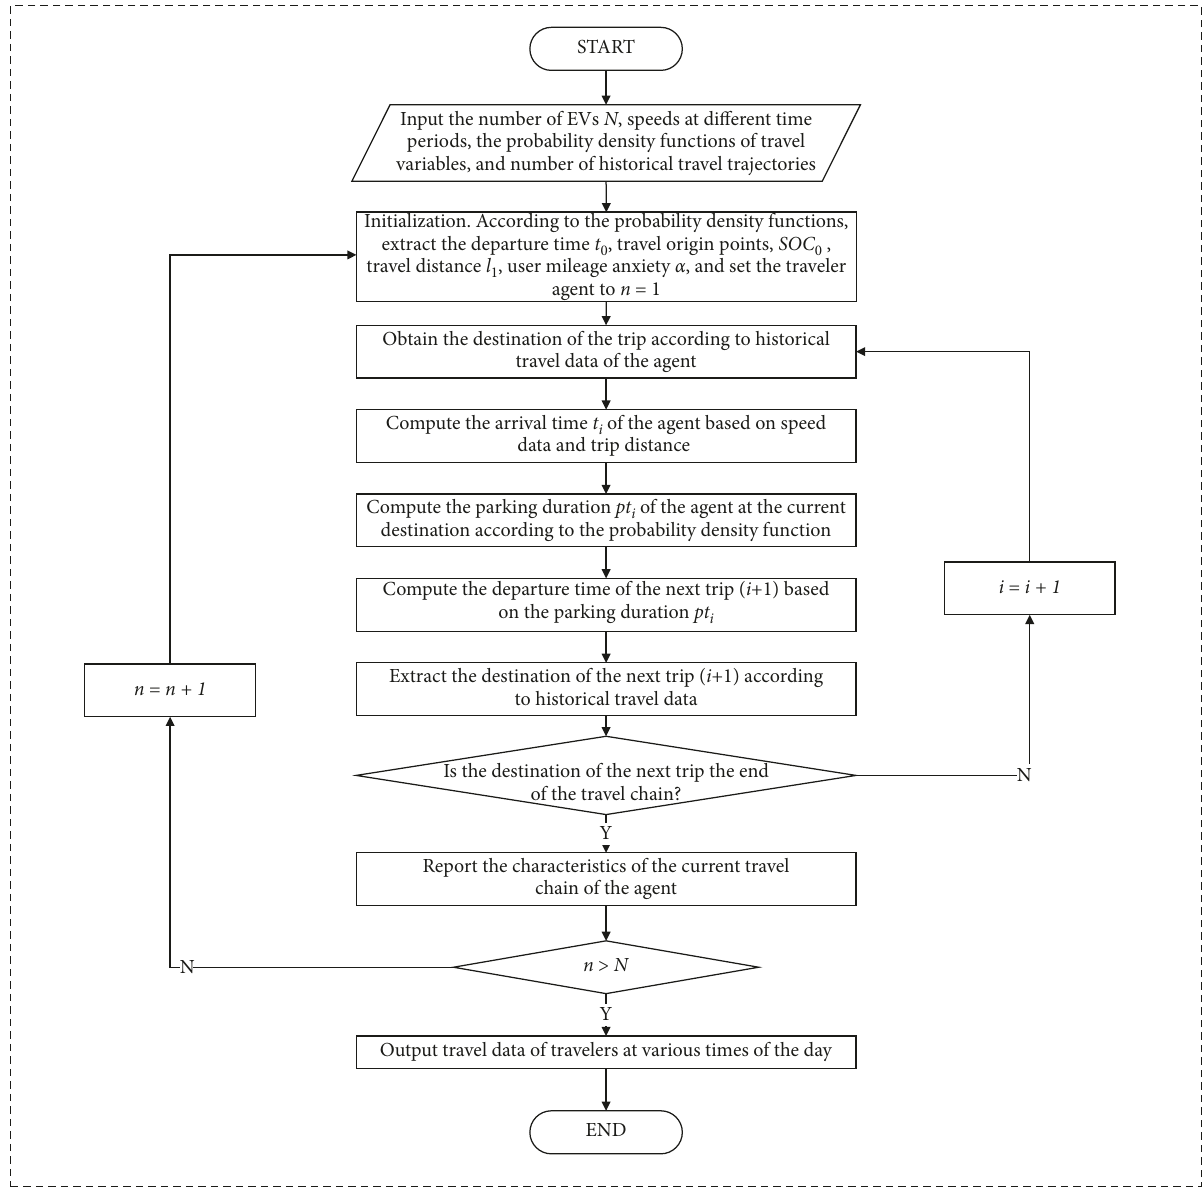
Figure 2: Simulation of daily travel